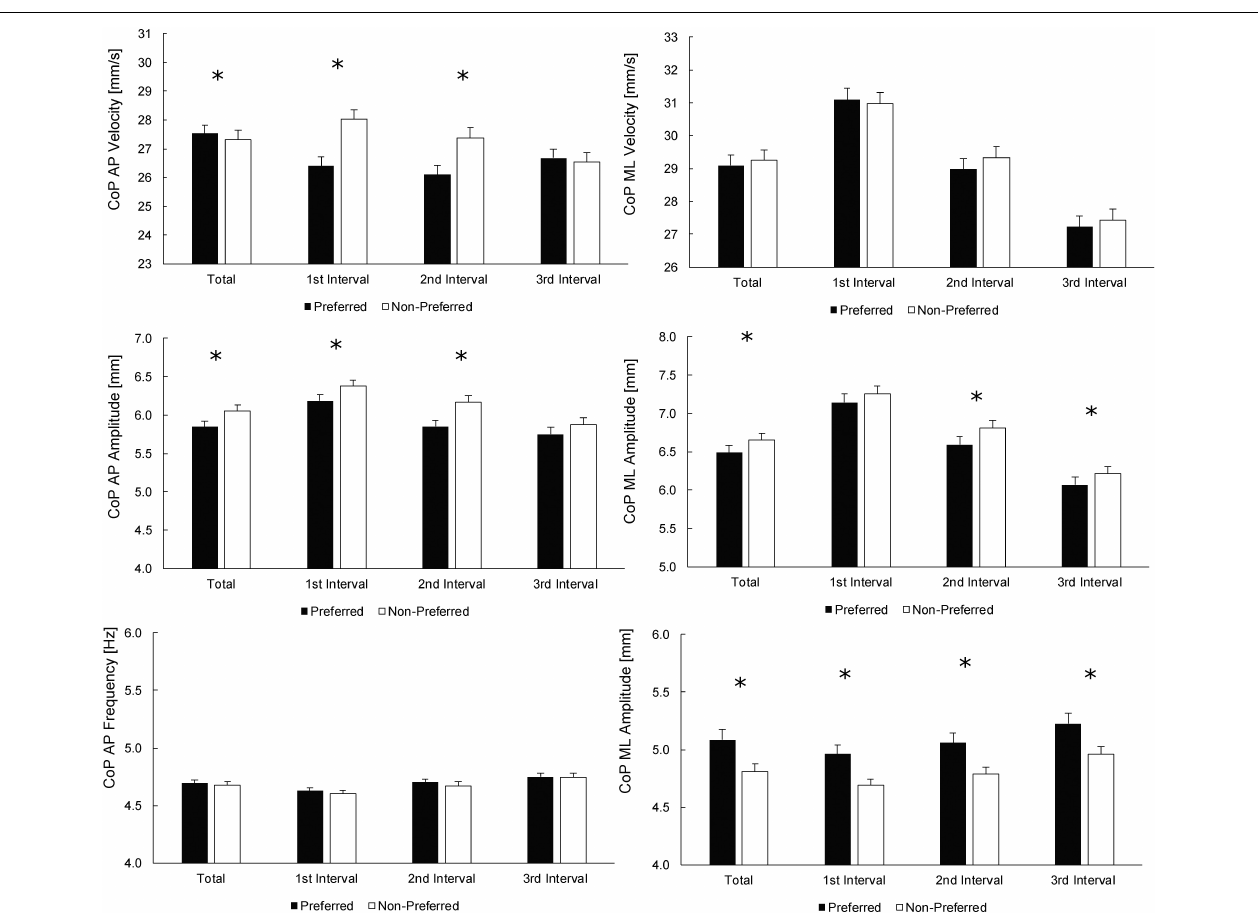
FIGURE 2 | Comparisons between the preferred and non-preferred legs (according to the classification related to handedness). Statistically significant differences between the legs for whole-trial (total; leftmost columns) values, as well as for individual time intervals, are denoted by asterisks. For main effects of leg and time intervals, see Table 2 (bottom